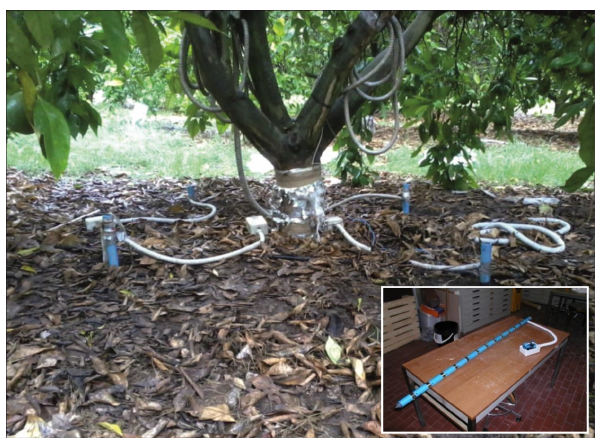
Figure 2. 3-D ERT apparatus installed around one orange tree. The system is composed of four micro-boreholes carrying 12 electrodes each (see inset) and 24 surface electrodes – see text and Fig. 3 for geometry details.